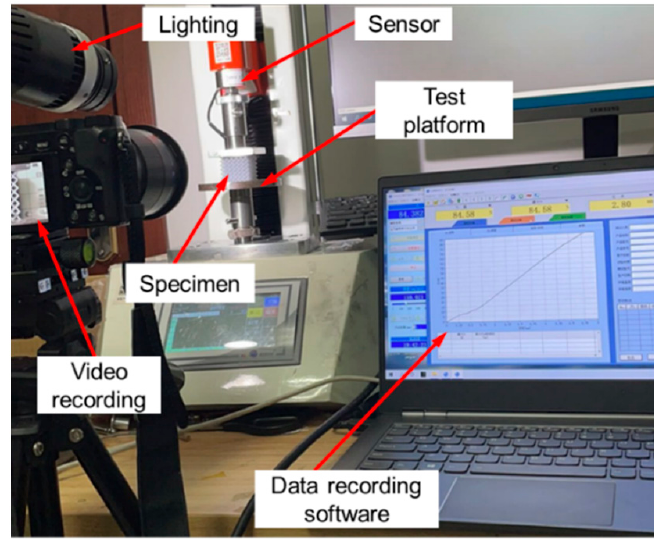
Figure 5. The in situ experiment platform for compression tests.